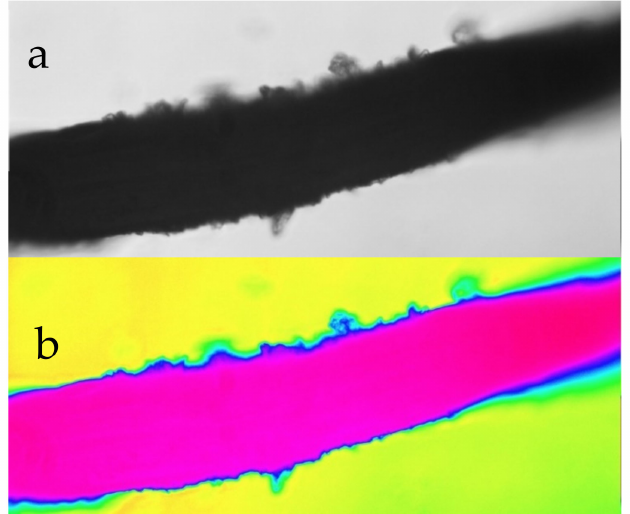
Figure 7. Detail of an iron fibre-coated with a [n-Fe(b)] p @[n-urea] a polymer catalyst. ( a ) transmitted light; ( b ) false colour. Field of view 0.4